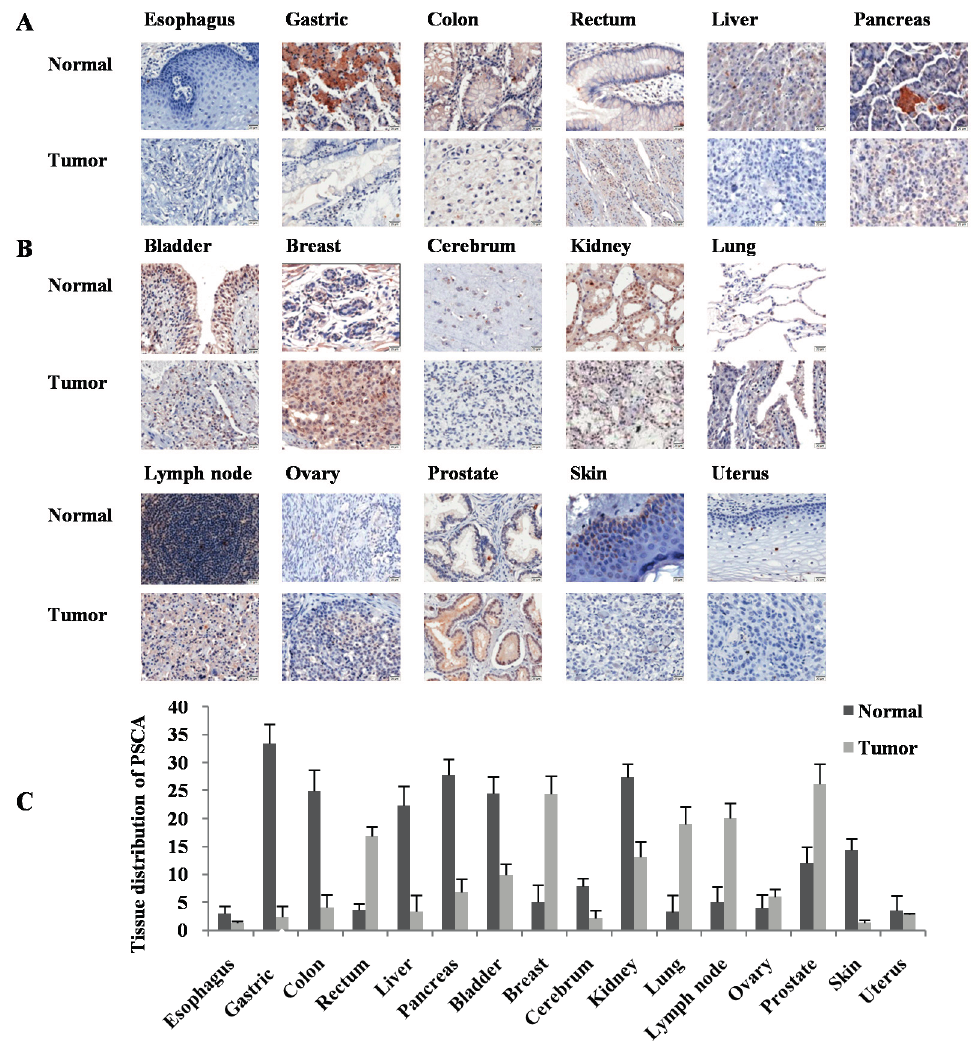
Figure 2. Analysis of PSCA protein expression and distribution in human normal and tumor tissues by tissue microarray. ( A ) Digestive system. Esophagus, negative in both normal and tumor tissues; gastric, colon, liver and pancreas: Positive in normal, negative or down-regulated in tumor tissues; rectum: Negative in normal, and positive in tumor tissues, Scale bar = 20 μ m, Magnification: ×200; ( B ) Non-digestive system. Bladder, cerebrum, kidney and skin: Positive in normal, and negative in tumor tissues; breast, lung, lymph node, ovary and prostate: Negative in normal, and positive in tumor tissues; uterus: Negative expression in both normal and tumor tissues, Scale bar = 20 μ m, Magnification: ×200; ( C ) Semiquantitative comparison of PSCA immunostaining scores between normal and tumor tissues by